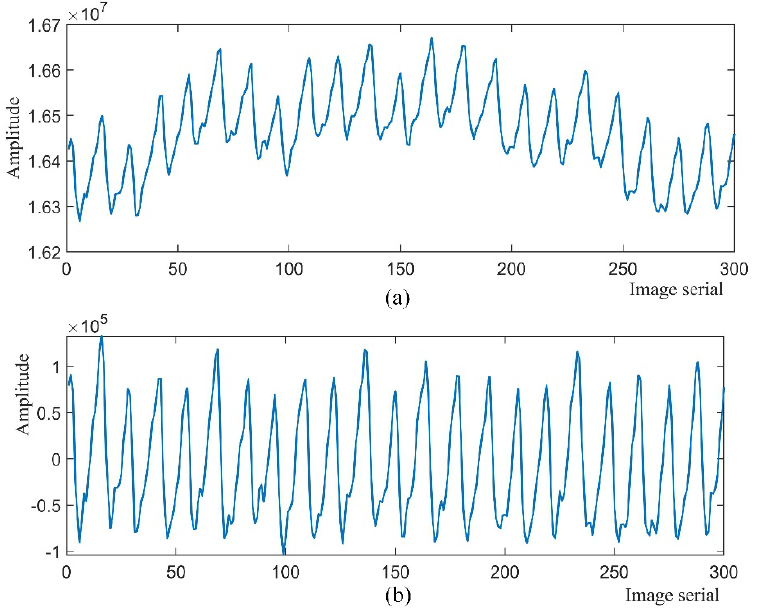
Figure 4. Pulse wave signal. ( a ) The original pulse wave signal and ( b ) the filtered pulse wave signal.